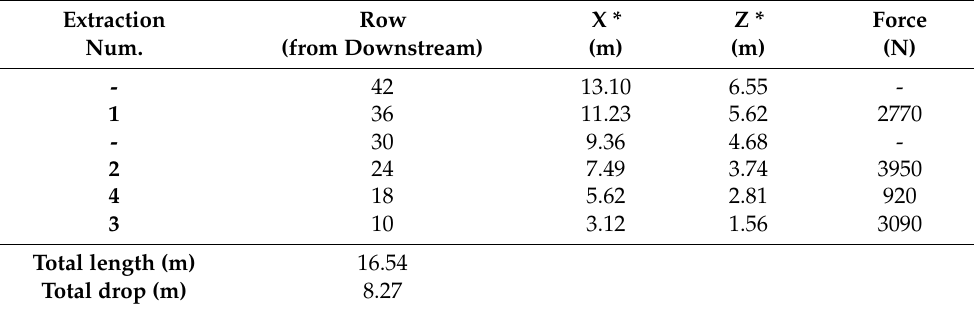
Table 3. Measurements of forces needed to extract the medium WSB after Test Session 1. Extraction Row Num. (from